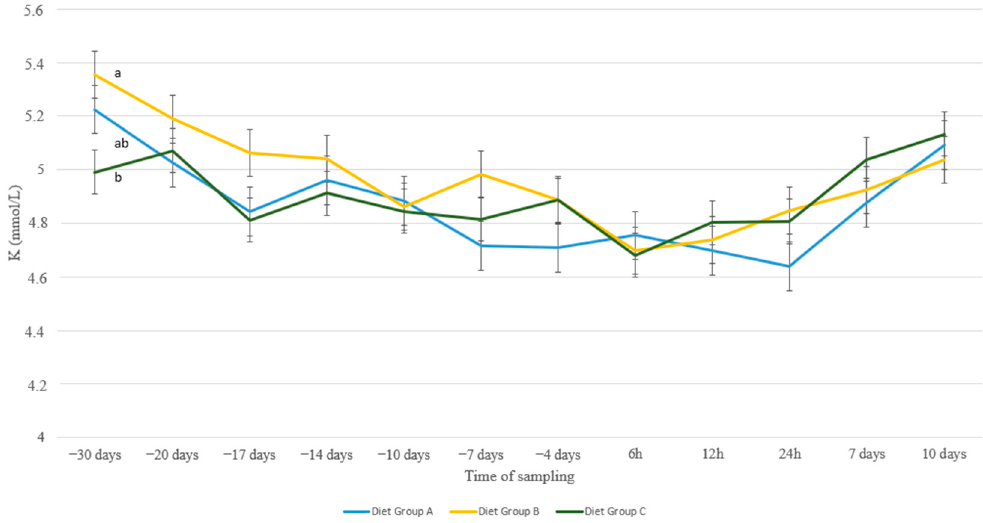
Figure 7. K levels (mmol/L) in blood serum of sheep in group A (control group, n = 27), group B (supplemented diet with beet pulp, n = 31), and group C (supplemented diet with beet pulp and ammonium chloride, n = 29) during the peri-parturient period. a,b Different letters denote significant differences between groups within evaluation time ( p < 0.05).